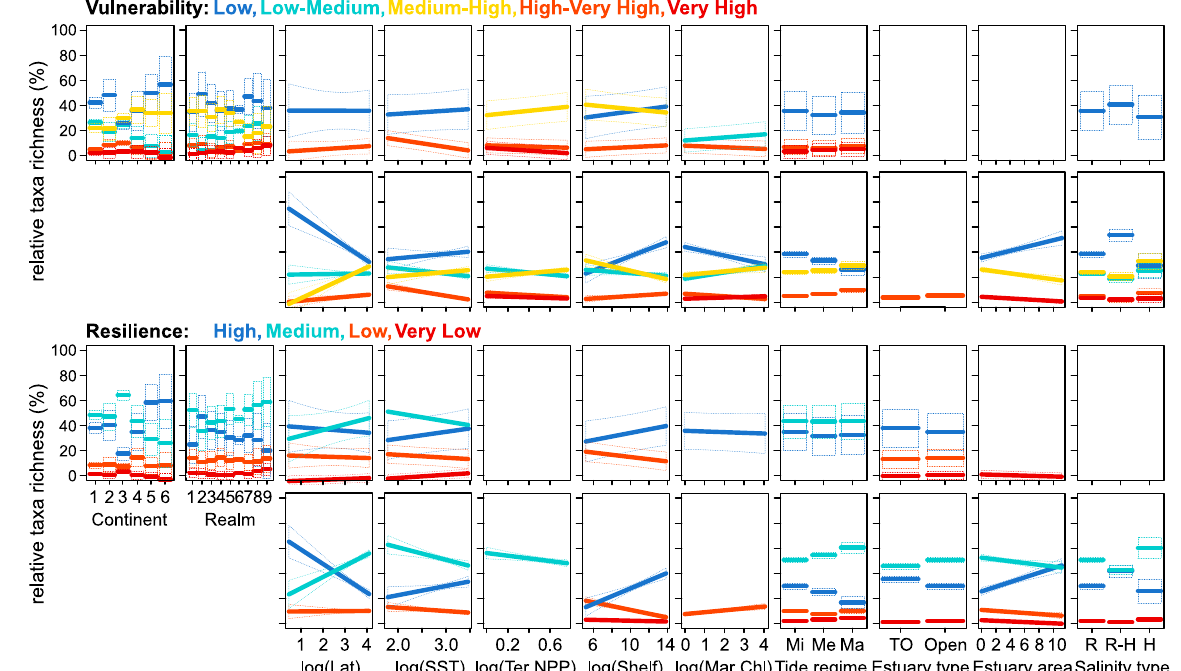
Figure 2. Relationships between fish traits (i.e. relative taxa richness of trait categories) of fish assemblages in sampled estuaries distributed worldwide and ecosystem features, according to fitted linear models. Traits considered are vulnerability, i.e. species intrinsic extinction vulnerability to fishing Low (dark blue), Low-Medium (light blue), Medium-High (yellow), High-Very High (orange), Very High (red) and resilience, i.e. species productivity or resilience to fishing High (dark blue), Medium (light blue), Low (orange), Very Low (red). Ecosystem features represented are: continent (1- North America, 2- South America, 3- Europe, 4- Africa, 5- Asia, 6- Oceania), marine biogeographical realm (1- Temperate Northern Pacific, 2- Tropical Eastern Pacific, 3- Temperate South America, 4- Temperate Northern Atlantic, 5- Tropical Atlantic, 6- Temperate Southern Africa, 7- Western Indo-Pacific, 8- Central Indo-Pacific, 9- Temperate Australasia), latitude (for representation purposes only), sea surface temperature (SST), terrestrial net primary productivity (Ter NPP), marine chlorophyll a (Mar Chl), continental shelf width (Shelf), tidal regime (Mi-microtidal, Me- mesotidal, Ma-macrotidal), estuary type (TO-temporarily open, O-open) and salinity type (R-regular, R-H- regular to hyperhaline, H-hyperhaline). Only predictors with relative importance above 0.5 in linear models are